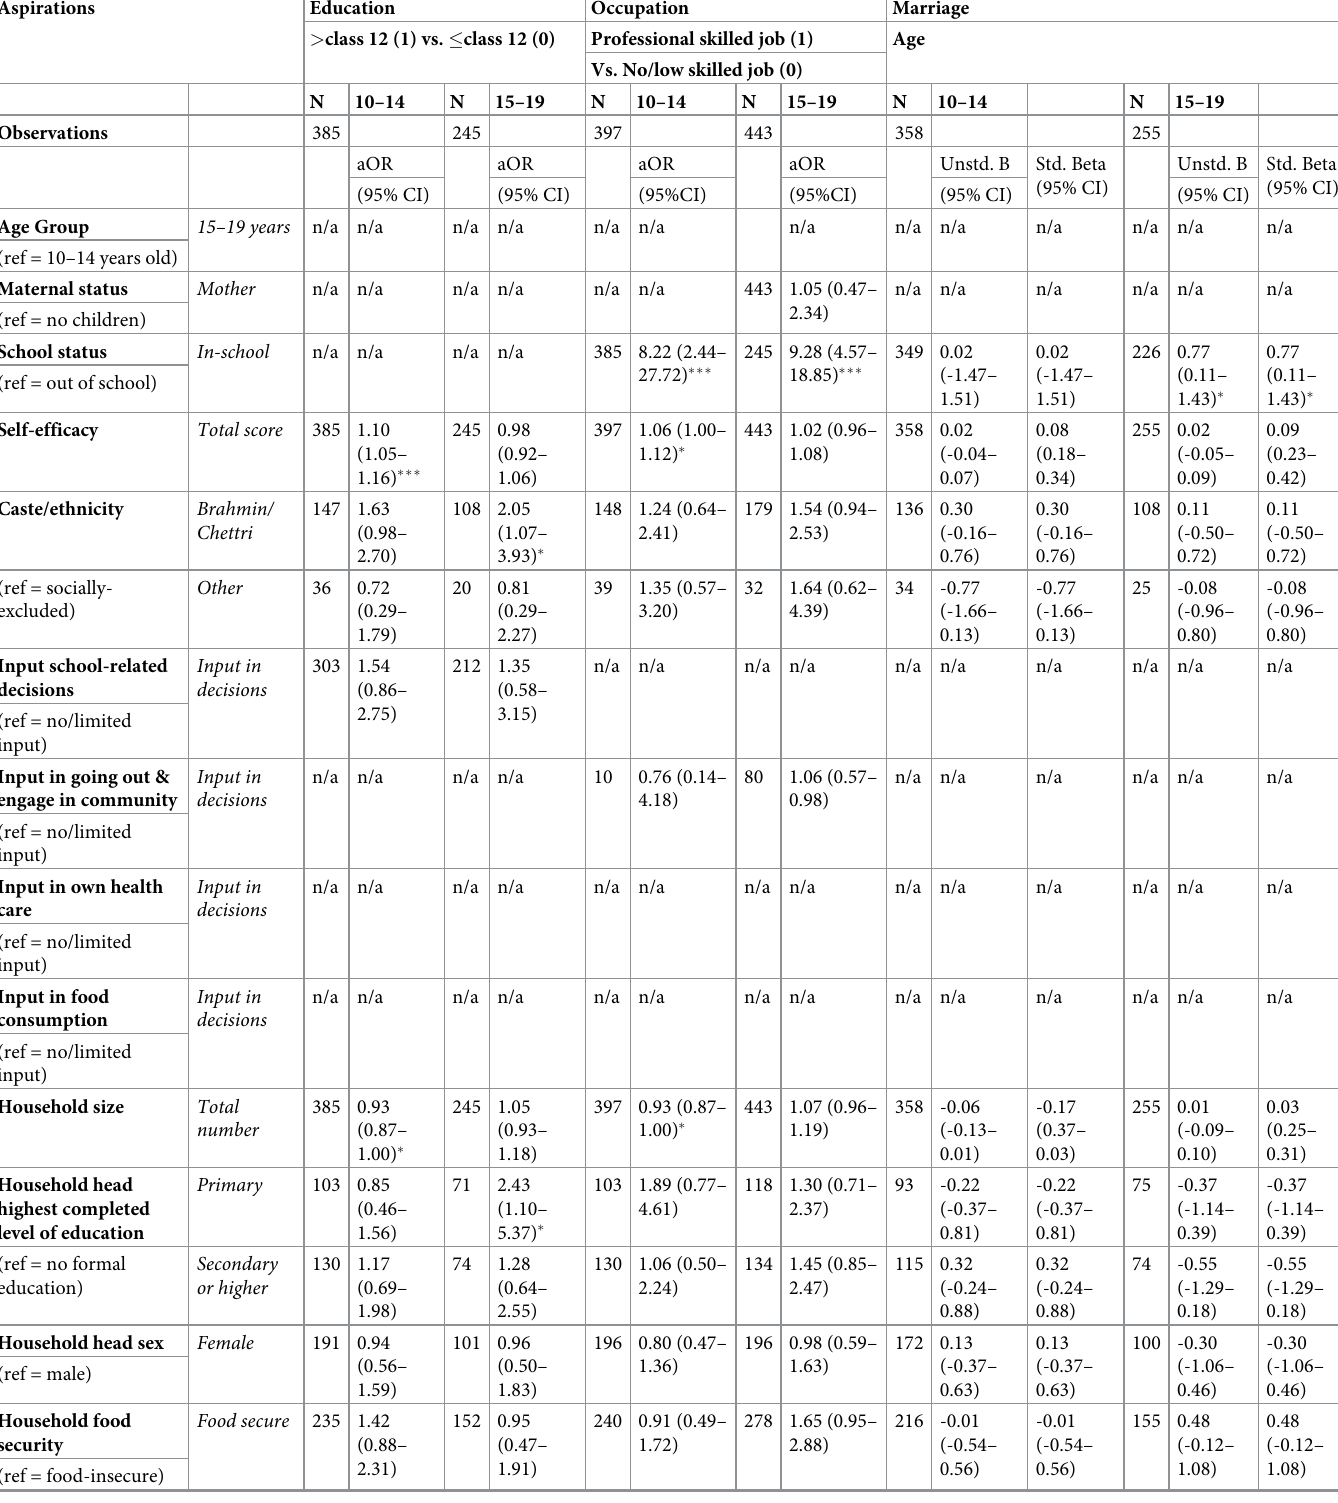
Table 4. Regression results for educational, occupational and marital aspirations split by age